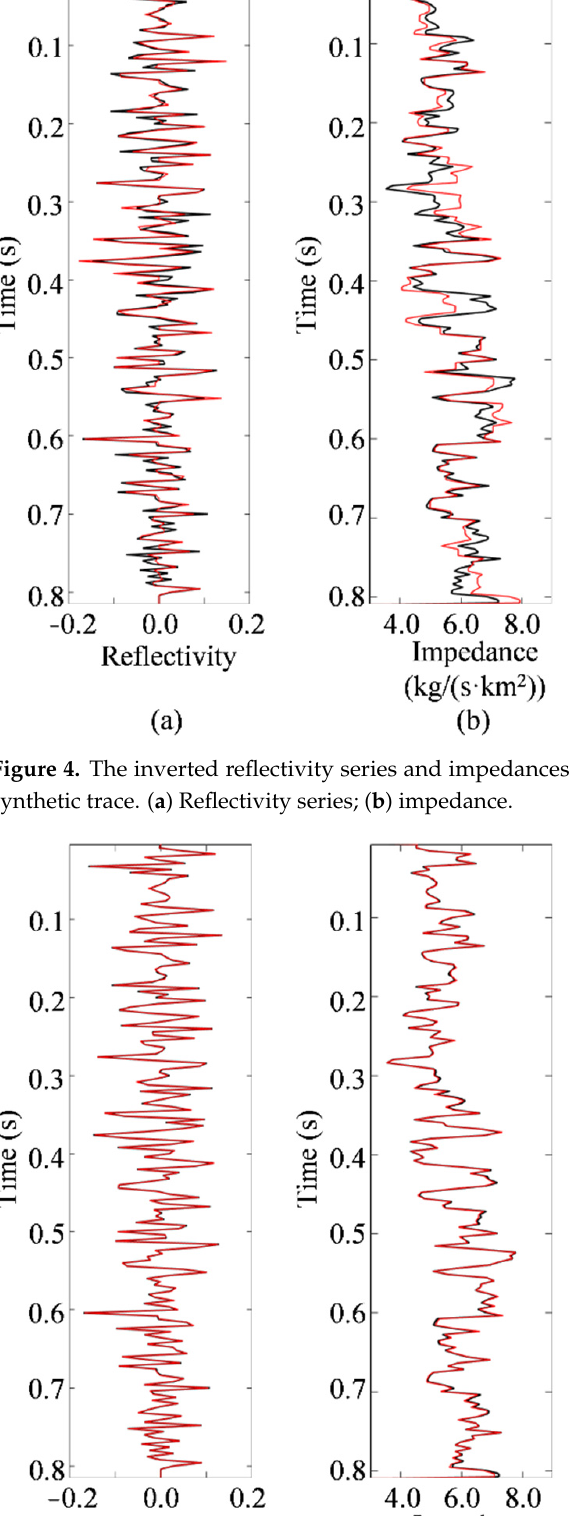
Figure 3. The inverted reflectivity series and impedance from L2RI performed on the noise-free synthetic trace. ( a ) Reflectivity series; ( b ) impedance.